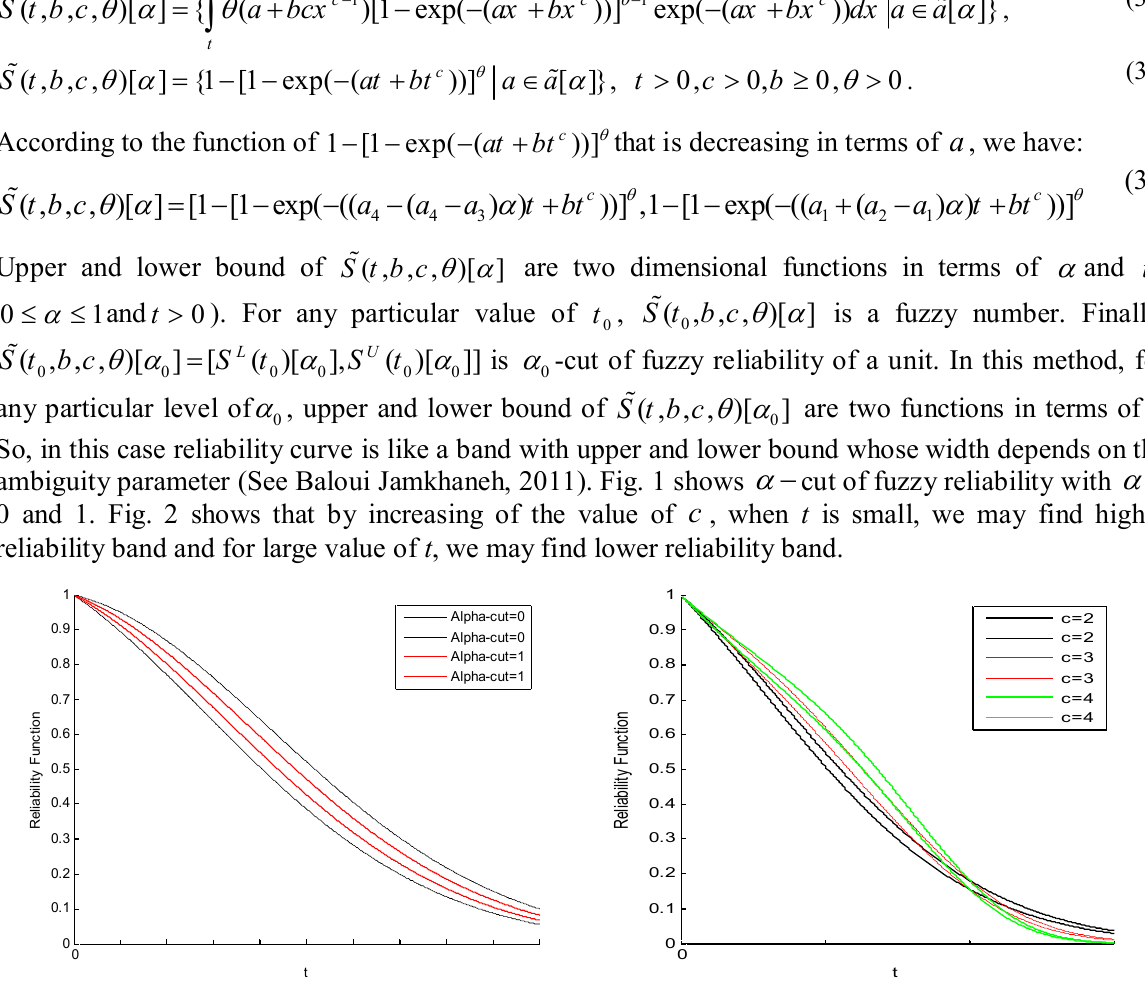
Fig. 1.  cut of fuzzy reliability for different t Fig. 2.  cut of fuzzy reliability for different c